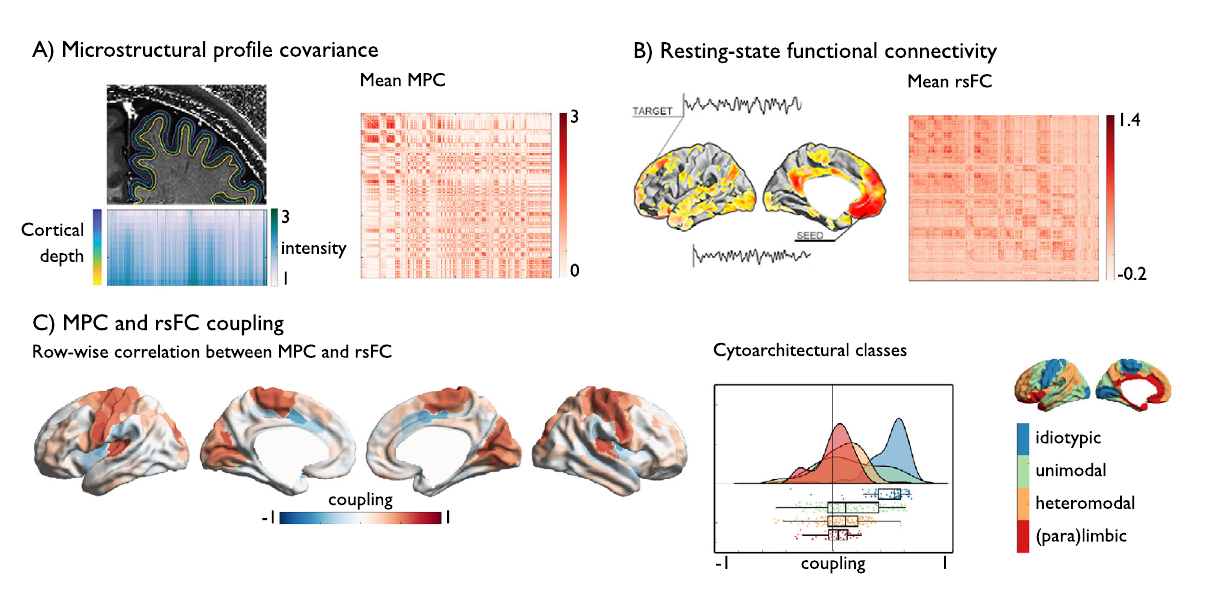
Fig. 1 Structure – function coupling and heritability in human cortical regions. A Microstructural pro fi le covariance (MPC) was chosen to map networks of microstructural similarity for each cortical node, sorted along cytoarchitectural class 22,59 ; B Resting-state functional connectivity (rsFC) analysis maps nodal patterns of intrinsic functional connectivity, sorted along cytoarchitectural class; C Row-wise coupling of MPC and rsFC Middle: raincloud plot of distribution within cytoarchitectural classes of coupling in the 400 Schaefer parcels, box shows the median and interquartile (25 – 75%) range, whiskers depict the 1.5*interquartile range (IQR) from the quartiles; Right: Reference visualization cytoarchitectural class. Source data are provided as a Source Data fi